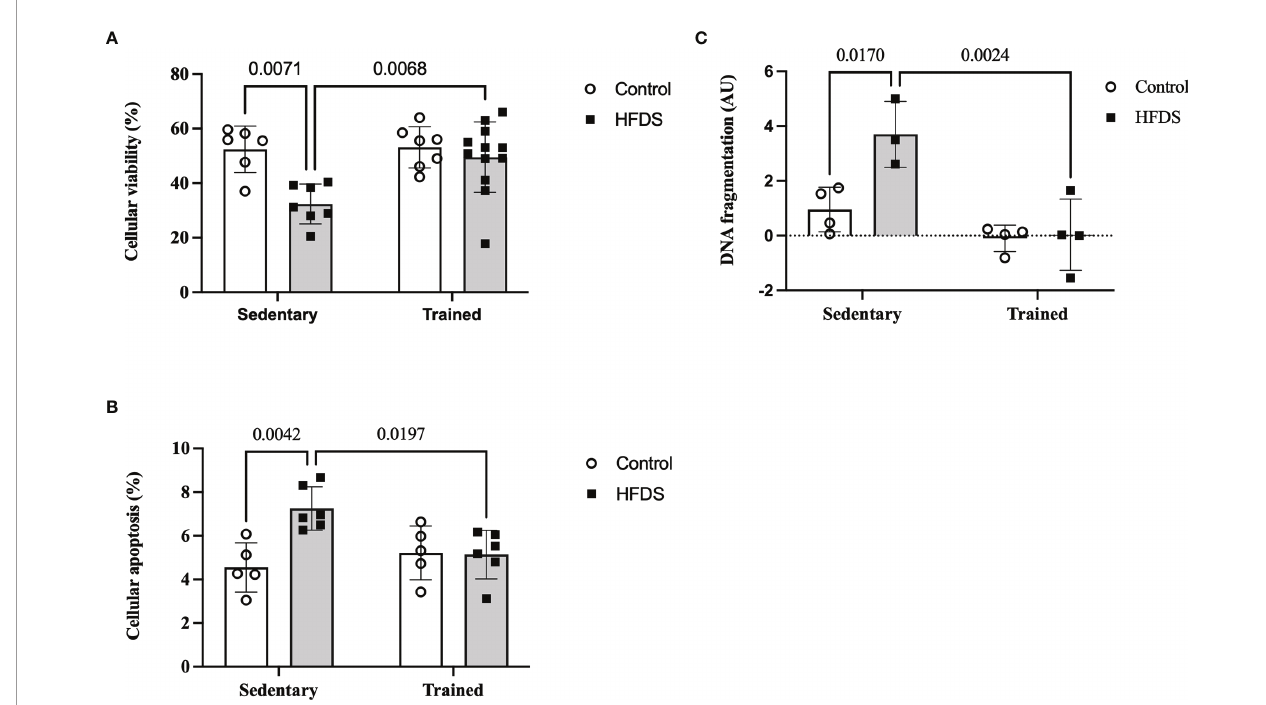
FIGURE 5 | Dispersed pancreatic islet after the eight-week intervention in the C, CTR, HFDS and HFDSTR groups. (A) Percentage of viable pancreatic cells: C vs. HFDS and HFDS vs . HFDSTR (P<0.05). (B) Cellular apoptosis: C vs. HFDS and HFDS vs. HFDSTR (P<0.05). (C) DNA fragmentation: C vs. HFDS and HFDS vs . HFDSTR (P<0.05). Data are expressed as the mean ±